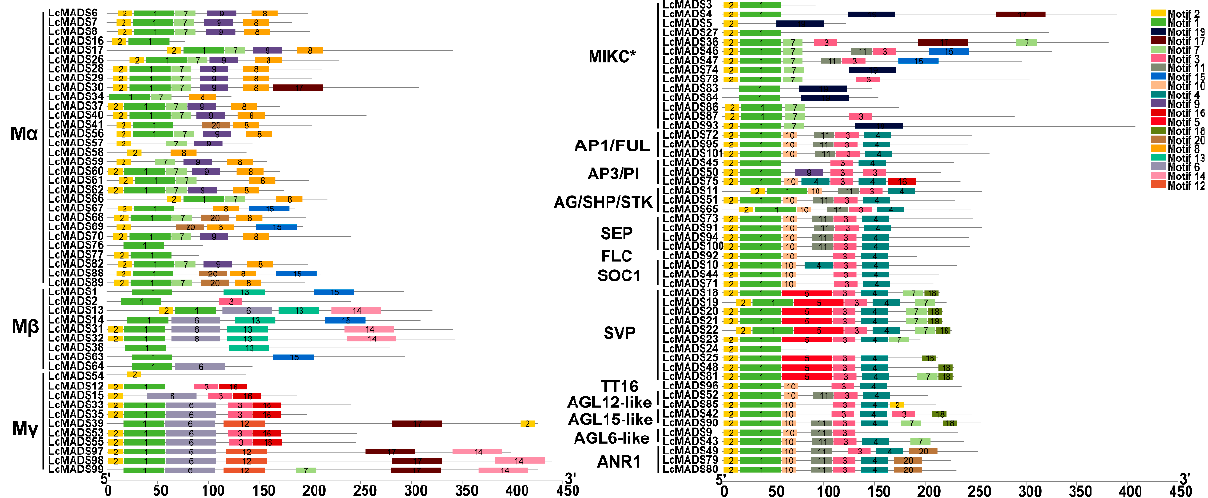
Figure 5. Conserved motif composition of litchi MADS-box proteins. The motifs, numbered 1–20, are indicated with colored boxes. The specific motif information is provided in Table S2. Type I genes are shown on the left and type II genes are shown on the right.